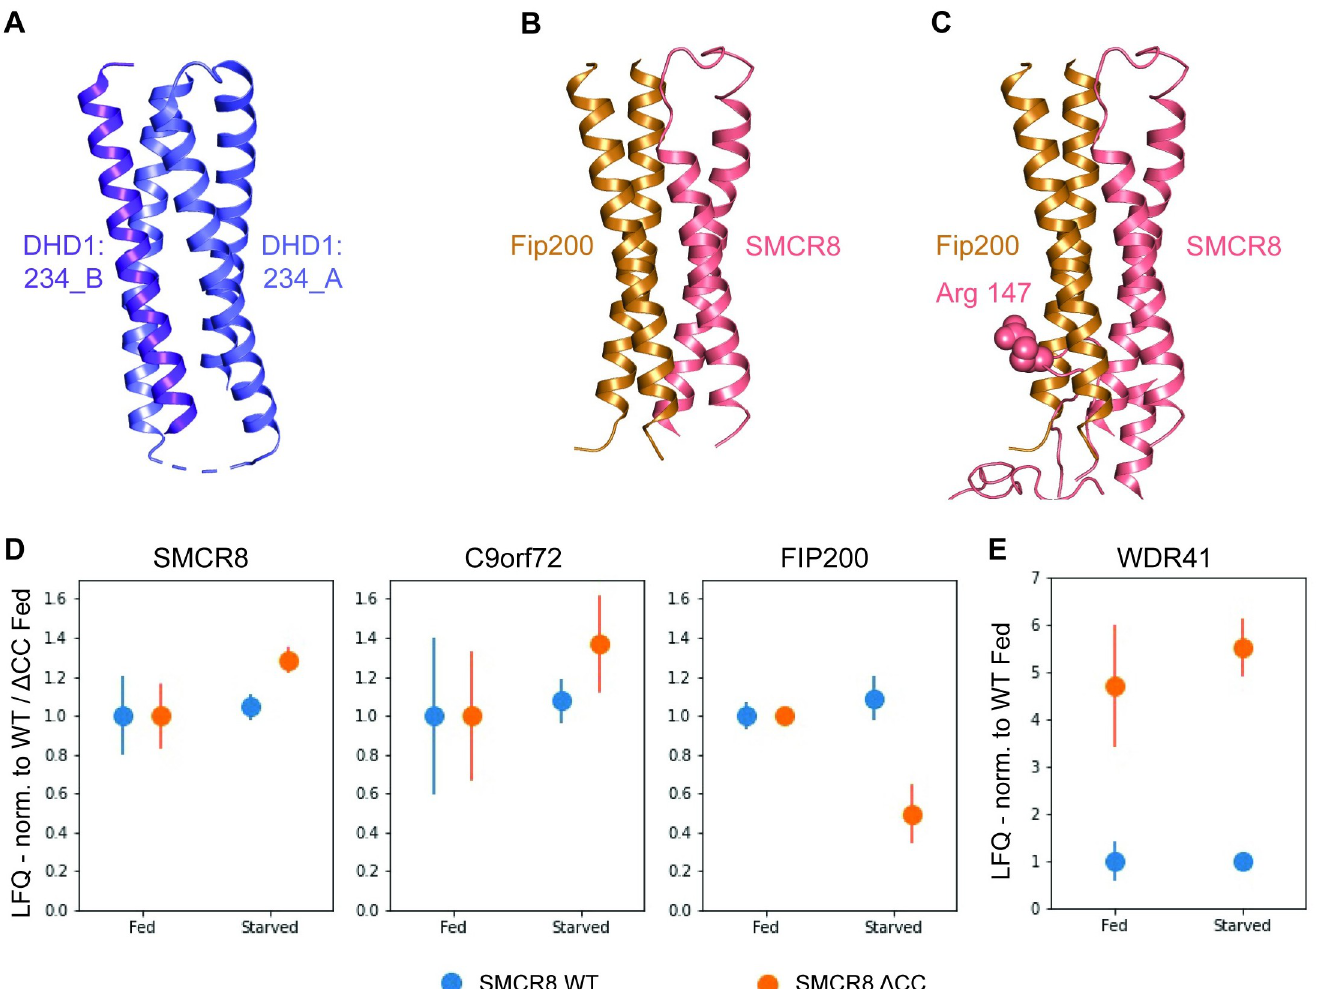
Fig 5. Structural and biochemical analysis of the SMCR8 coiled-coil region. (A) Structure of an artificial 4 helix bundle generated by 2 monomers (PDB: 6DLC) (blue and purple) [39]. (B) Model of a 4-helix bundle formed by SMCR8 N-C coiled coil (salmon pink) and FIP200 coiled-coil dimer (brown, PDB: 6GMA) [40] based on the artificial 4 helix bundle (PDB: 6DLC) [39]. (C) Model of SMCR8 coiled coil bound to FIP200 coiled-coil dimer along with the uDenn domain of SMCR8. Arg 147 of SMCR8 is shown in sphere representation. (D) Reduction in interaction between C9orf72-SMCR8 Δ CC with FIP200 upon starvation. Fold change in the LFQ values of C9orf72 and SMCR8 Fl (WT, blue) or SMCR8 Δ CC ( Δ CC, orange) and FIP200 (normalized to the Fed condition) are shown. Standard error of the mean is shown. (E) Increased interaction between C9orf72-SMCR8 Δ CC and WDR41. Fold change in the LFQ values of WDR41 (normalized to the WT Fed condition) is shown for both SMCR8 Fl (WT, blue) or SMCR8 Δ CC ( Δ CC, orange) pull-down experiments. Standard error of the mean is shown. Student t test: WDR41 Fed WT/ Δ CC, p = 0.091; WDR41 Starved WT/ Δ CC, p = 0.004; N = 3. The LFQ intensities and the corresponding analysis can be found in S2 Data. CC, coiled coil; Denn, differently expressed in normal and neoplastic cells; LFQ, label-free quantification; PDB, Protein Data Bank; uDenn, upstream Denn; WT,